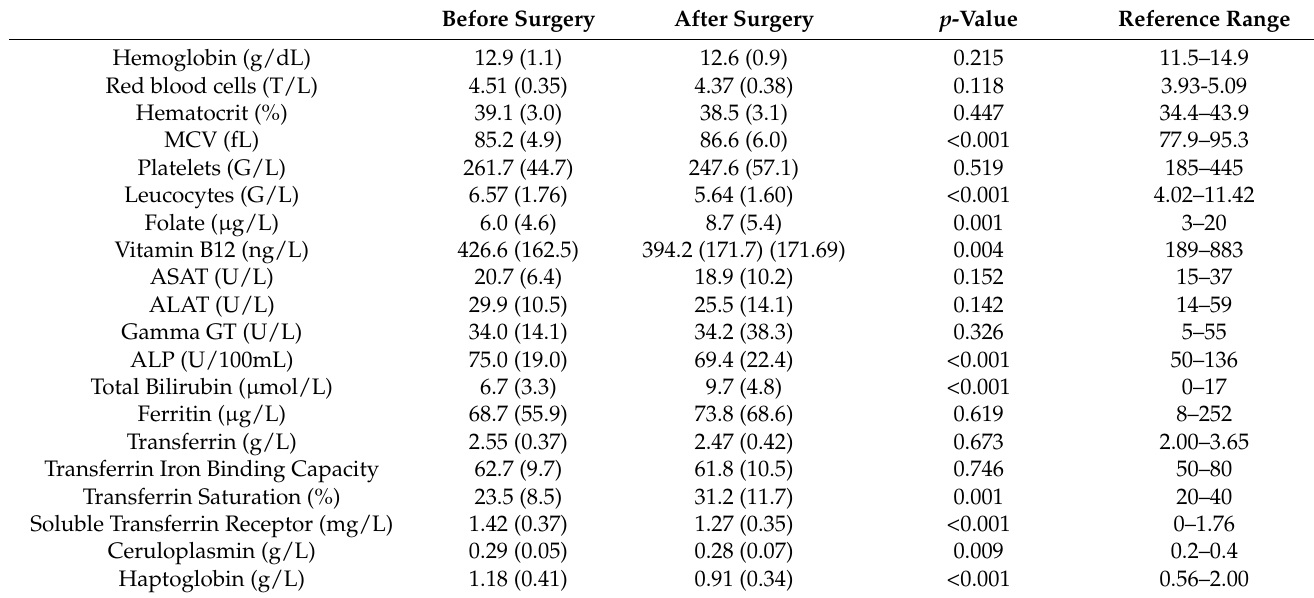
Table 2. Biological markers’ evolution before and after surgery on the population of 55 patients. Before